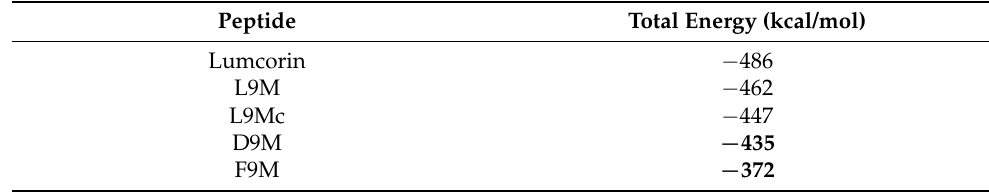
Bold numbers correspond to values averaged over the different relevant conformations.